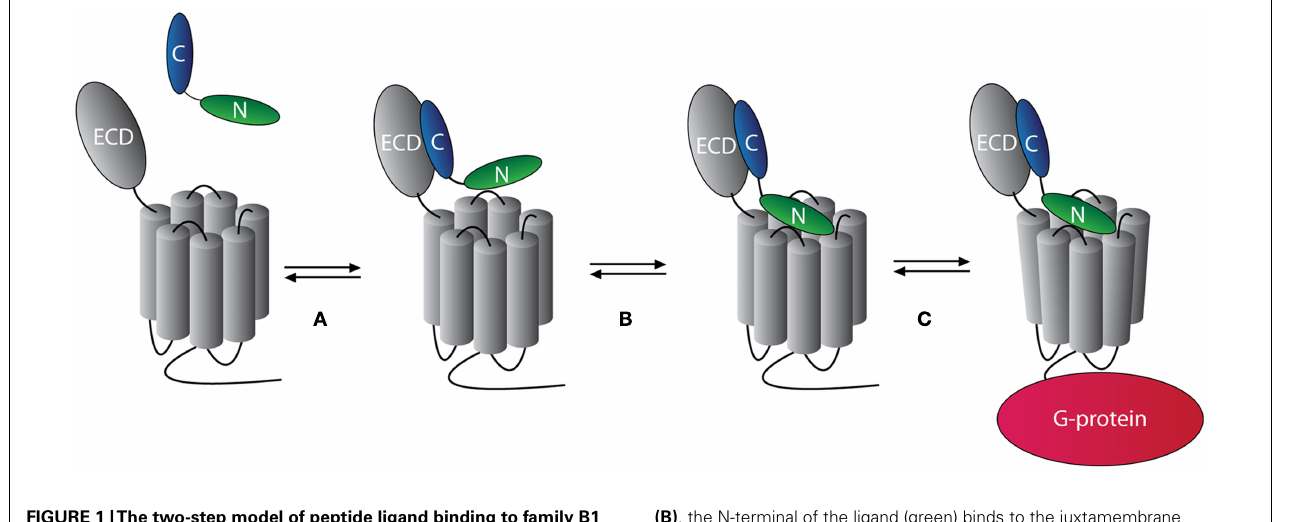
FIGURE 1 |The two-step model of peptide ligand binding to family B1 GPCRs. The binding of one ligand to one family B1 GPCR occurs in two steps. In step (A) the C-terminal portion of the ligand (blue) binds to the N-terminal domain of the receptor with high affinity and specificity. In step